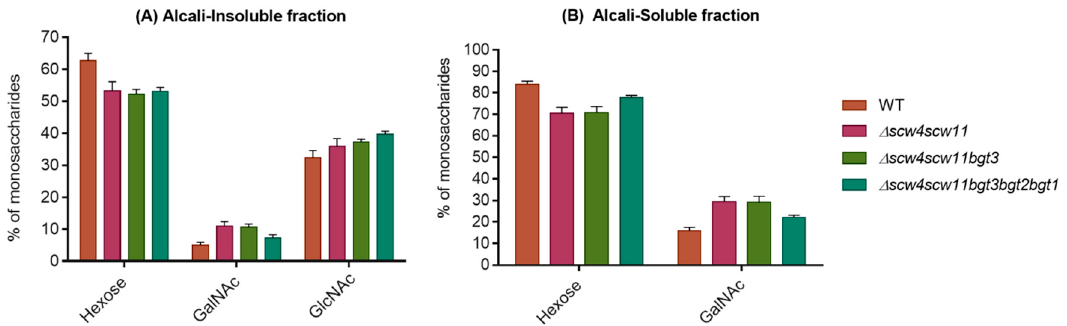
Figure 7. Percentage of hexose, N -acetylgalactosamine (GalNAc), and N -acetylglucosamine (GlcNAc) in the alkali-insoluble ( A ) and alkali-soluble fraction ( B ) of the cell wall of the double, triple, and quintuple mutants of the GH17 family. Values are mean ± SD of three independent determinations. WT, parental strain.